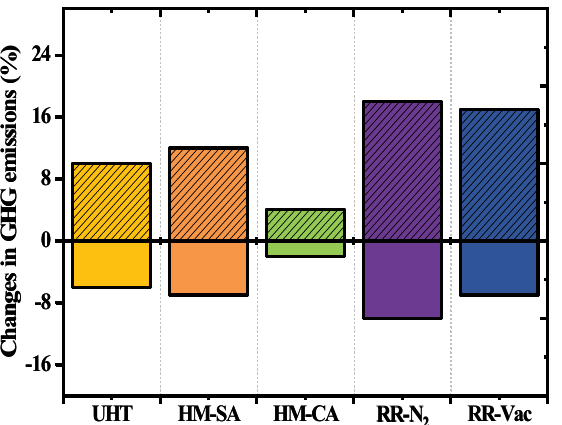
Figure 11. Sensitivity analysis of the GHG emissions for the recycling methods with different electricity sources.